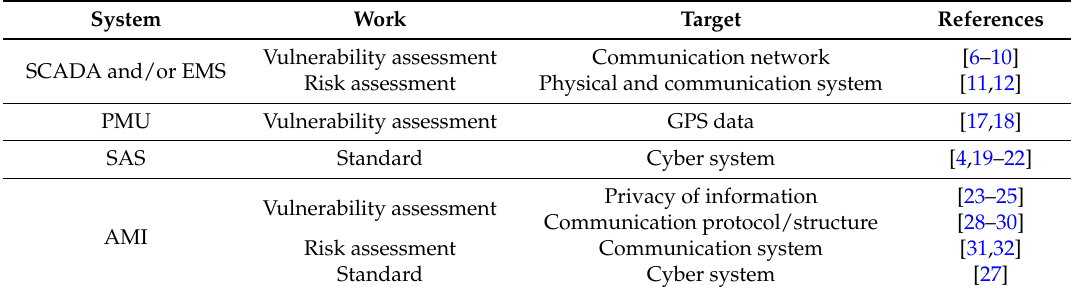
Table 2. Overview of SCADA, PMU, SAS and